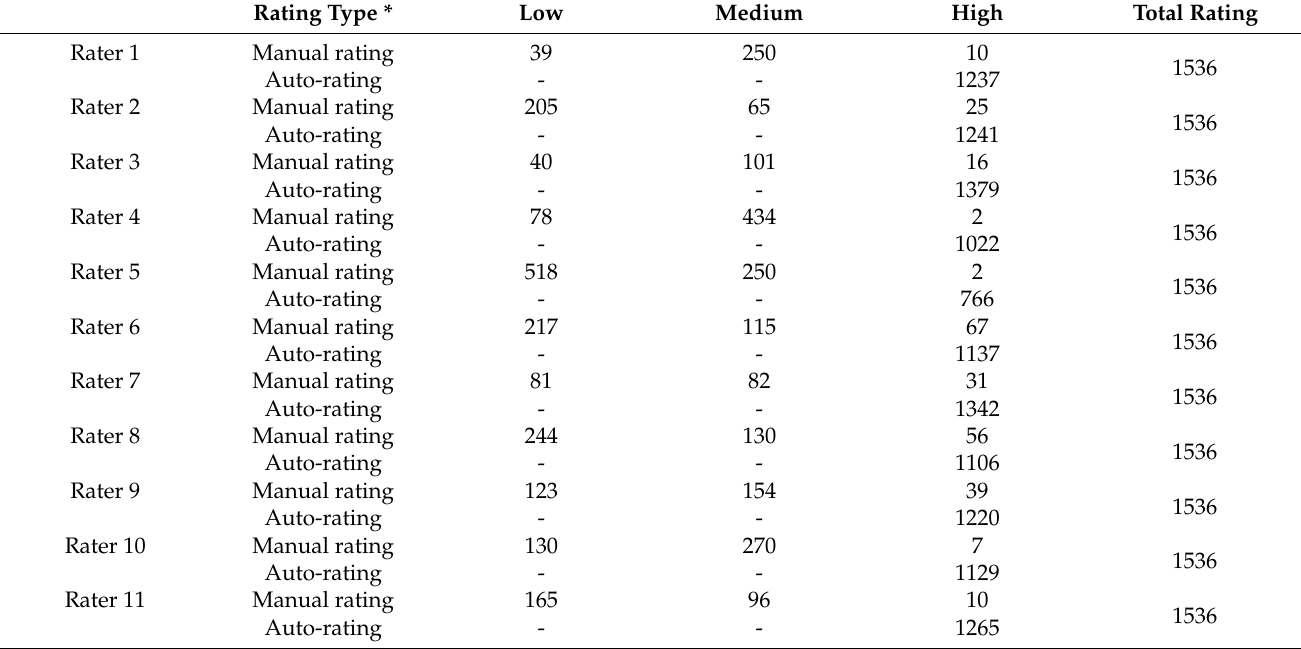
Table 3. Summary of class of rating by expert rater.